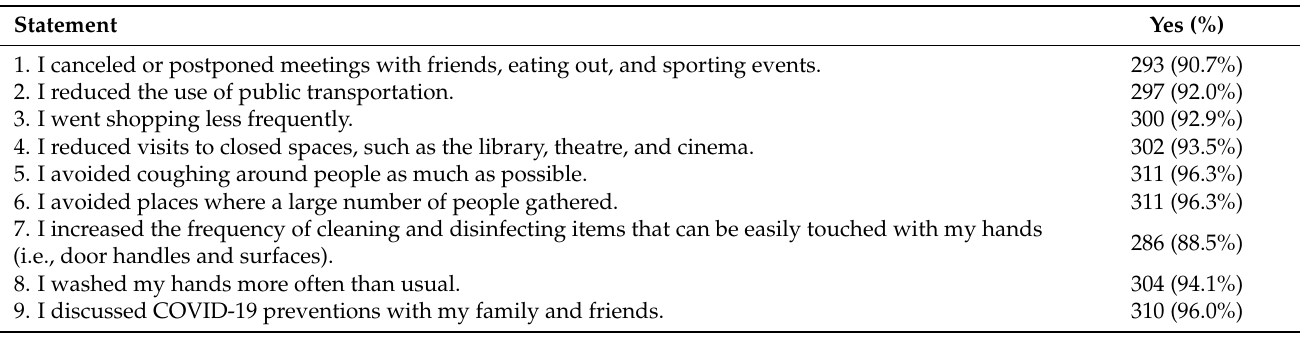
Table 3. Assessment of self-reported preventive behavior of medical students in response to COVID-19 ( n =